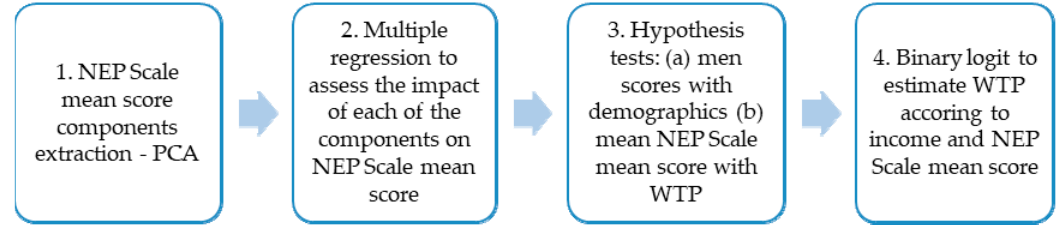
Table 2. Total variance explained by components.